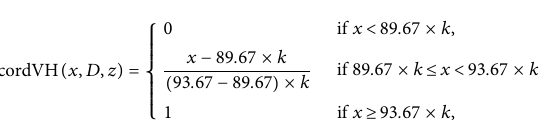
sky. Table 3 shows average percentage of accuracy for zenithal distances between 20 and 85 deg.